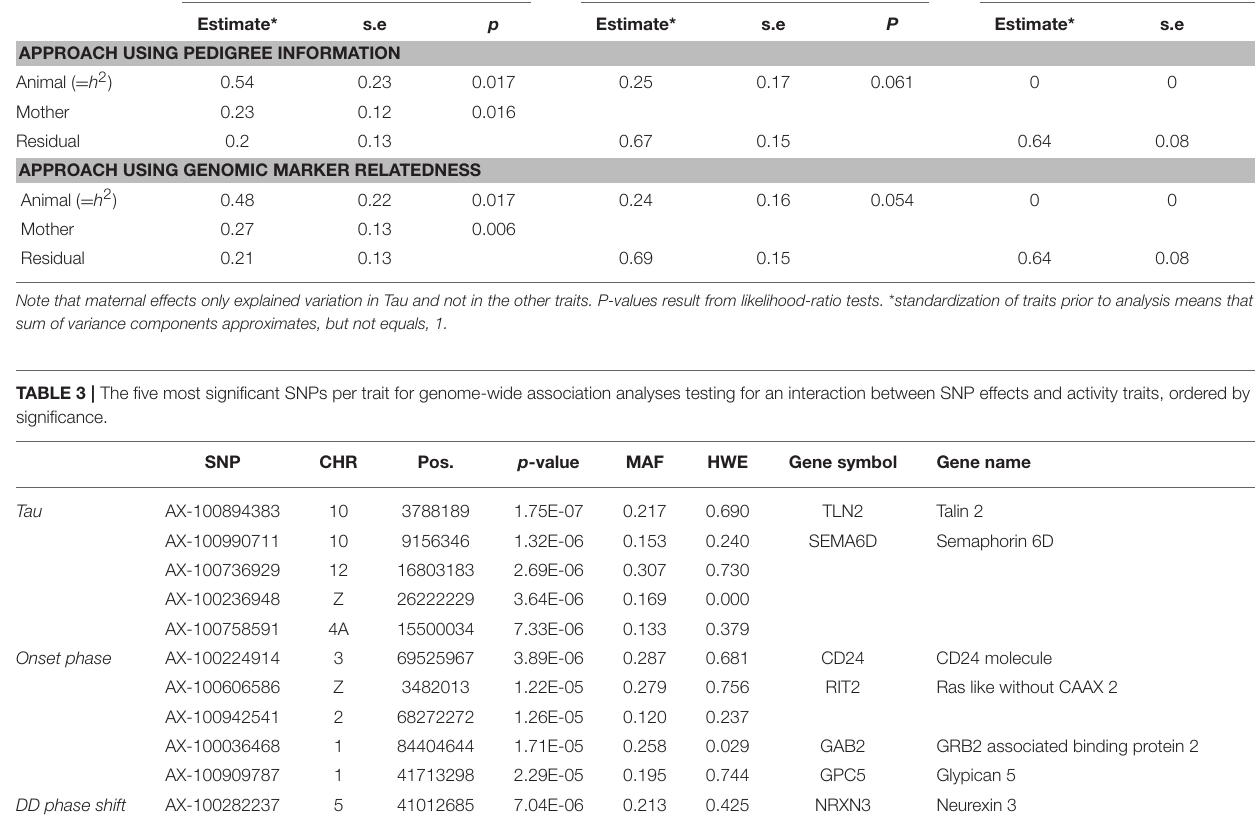
TABLE 2 | Estimates and standard errors for the variance components explaining variation in Tau , onset phase, and DD phase shift . Tau Onset phase